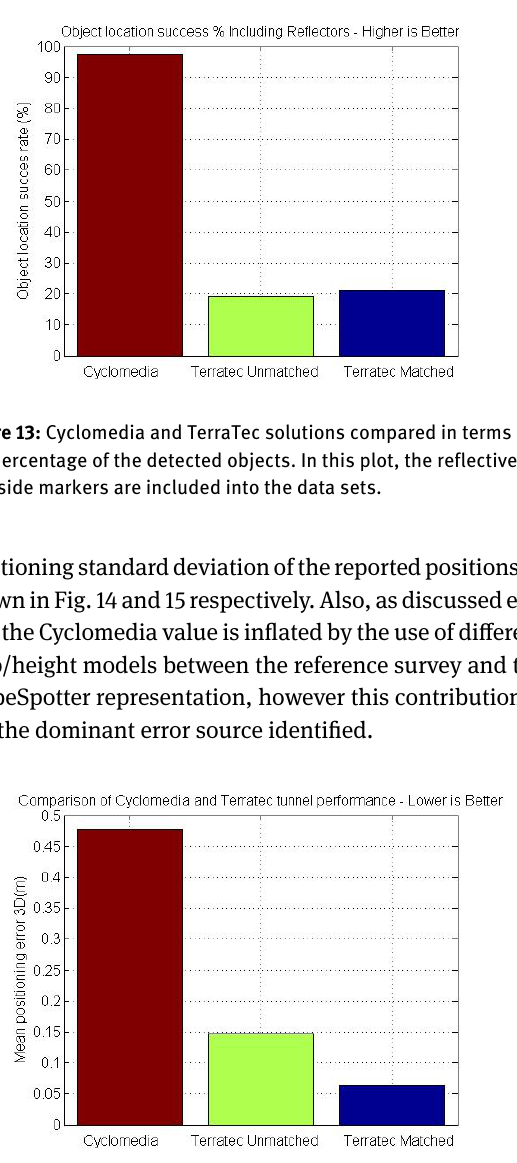
Figure 12: Cyclomedia and TerraTec solutions compared in terms of the percentage of the detected objects. In this plot, the reflective roadside markers were removed from the data sets since they were universally undetectable by the TerraTec system.